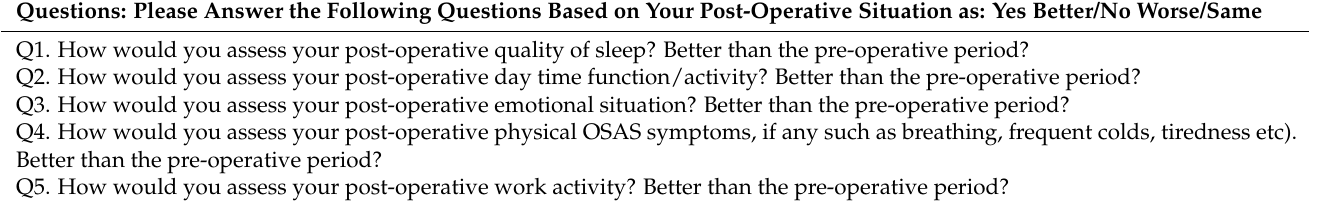
Table 2. Post-operative Quality of life